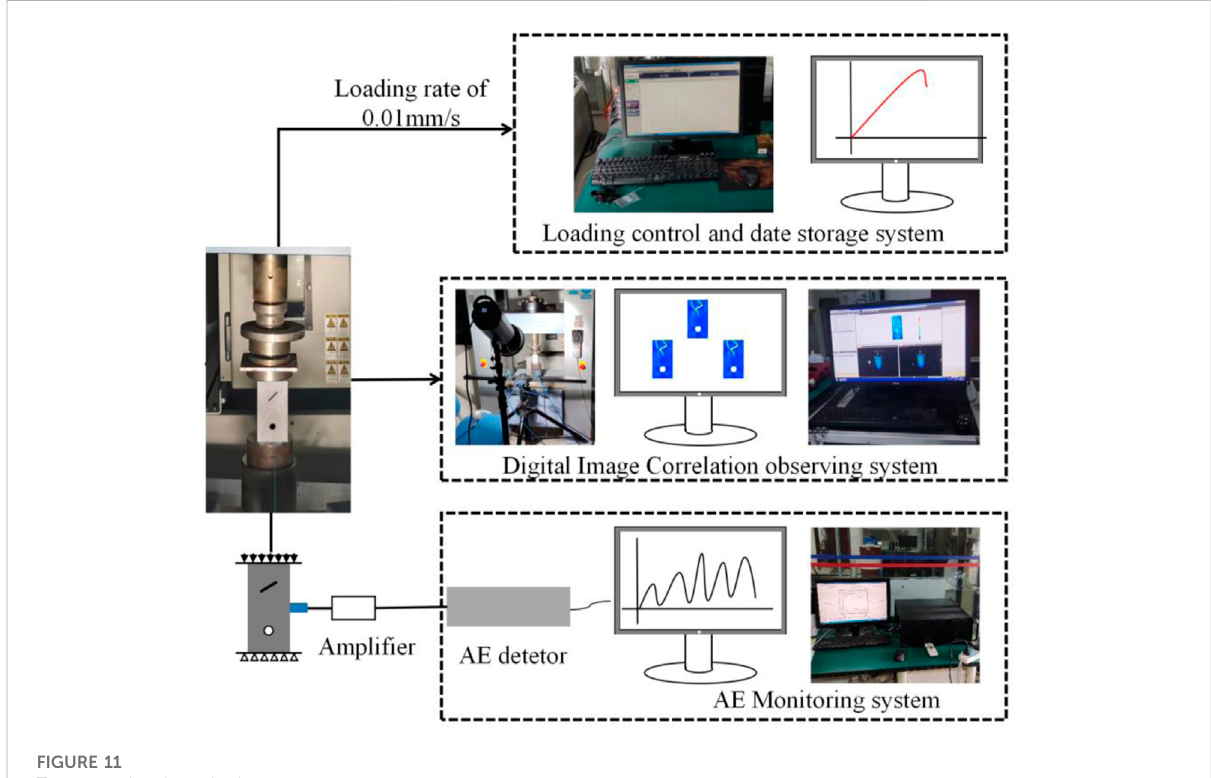
FIGURE 11 Test control and monitoring